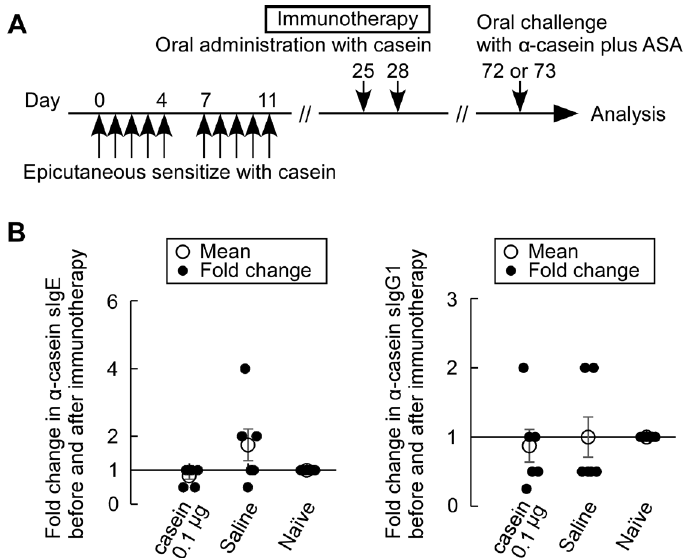
Figure 8. Changes in α -casein sIgE and sIgG1 levels by oral casein immunotherapy in adjuvant-free casein-sensitized allergy model mice. ( A ) Experimental protocol. As an oral immunotherapy, 0.1 µg/head of casein was administered orally two times on day 25 and 28 in sensitized mice. As a control, saline was administered orally. On day 72 or 73, mice were challenged with ASA and α -casein, then rectal temperature and symptom score were monitored ( n = 6/group); ( B ) Fold changes in serum α -casein sIgE and sIgG1 levels after immunotherapy of casein or saline in the sensitized and naïve mice. Serum samples were collected before immunotherapy on day 24 and, after, on day 64 ( n = 6/group).